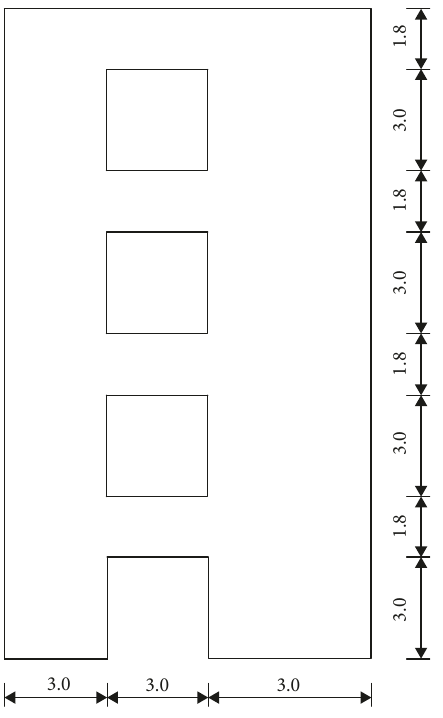
Figure 19: Shear wall with four